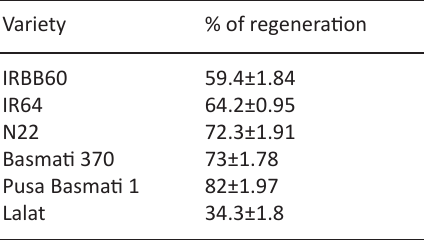
Table 2. Percentage of Regeneration in different indica rice genotypes Variety